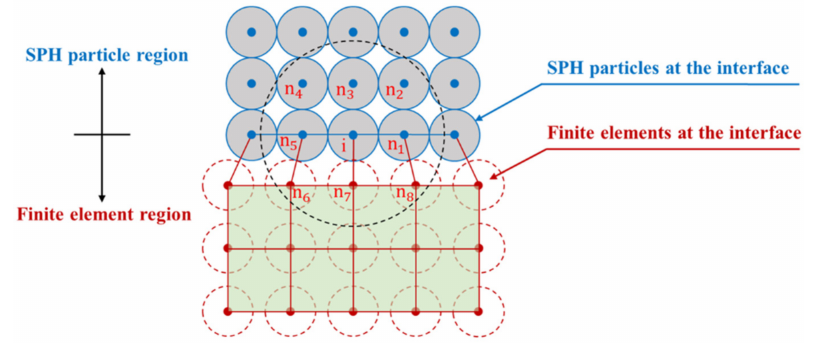
Figure 4. Attachment algorithm for the SPH–FEM coupling method.